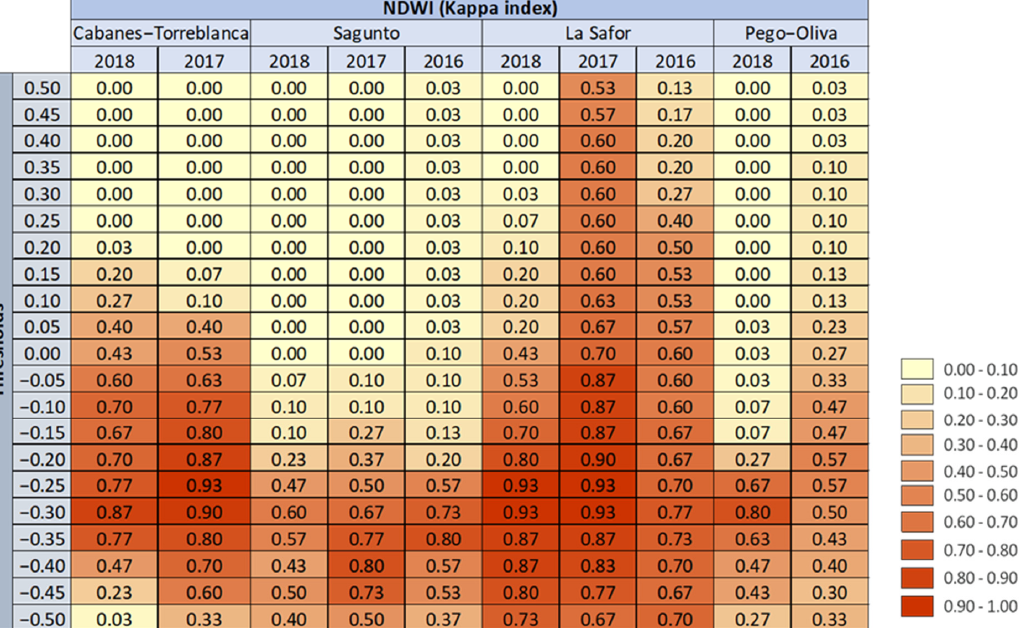
Figure 7. Kappa index of NDWI index tested at four studies areas and 3 years for the threshold range ( − 0.50 to 0.50).